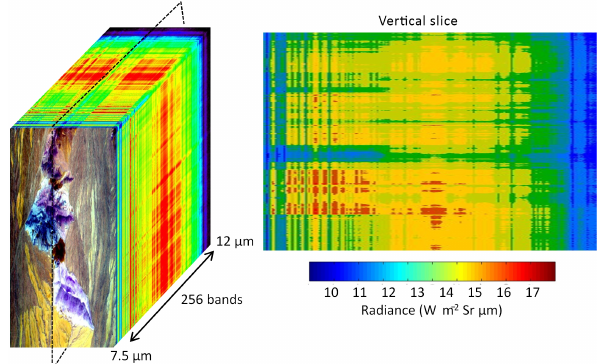
Figure 2. HyTES data hypercube over Death Valley, California. Ra- diances in the vertical slice have been atmospherically corrected for the atmospheric transmission and path